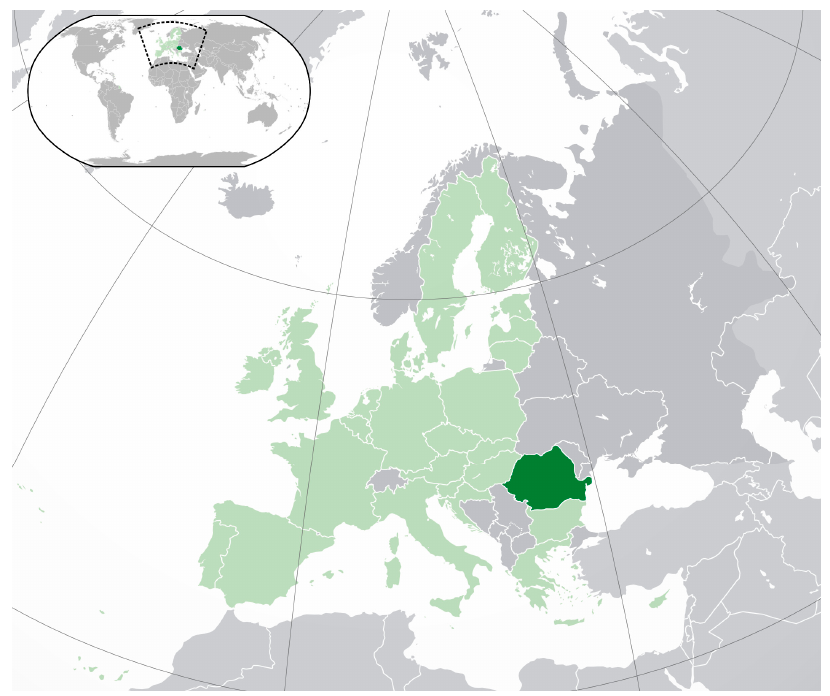
Figure 1. Location of Romania (dark green) in the European Union (green) and Europe (green and dark grey) [1].